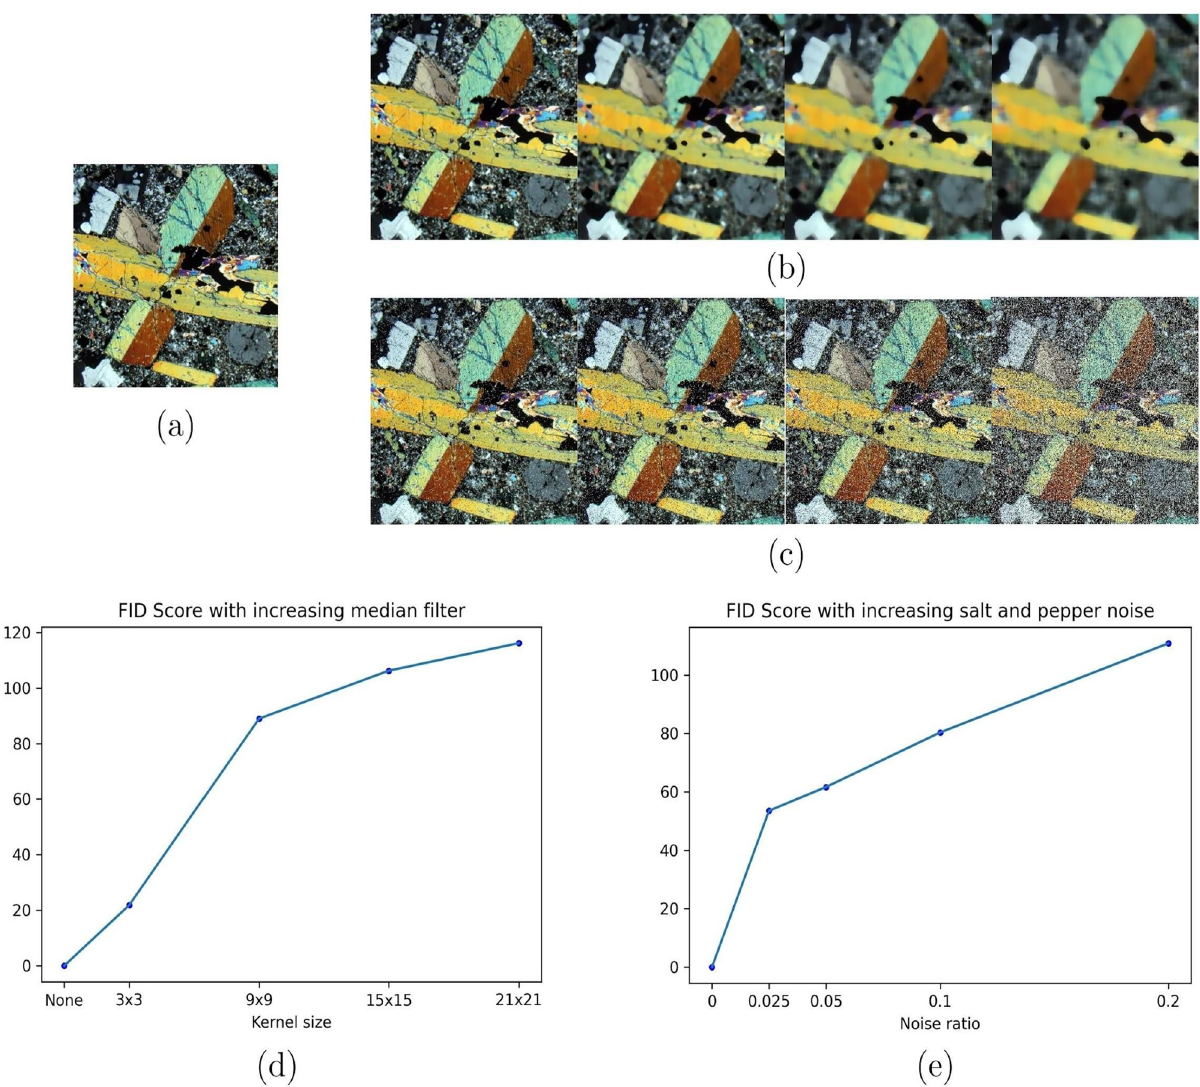
Figure 3. Comparison of different disturbances on FID score for a nepheline foidite from Streckeisen dataset; ( a ) Original image, ( b ) increasing the kernel size median filter applied to the original image, ( c ) adding salt and pepper noise to the image, ( d ) increase in FID score for corresponding kernel size in median filter, and ( e ) increasing the noise-to-signal ratio effect on FID